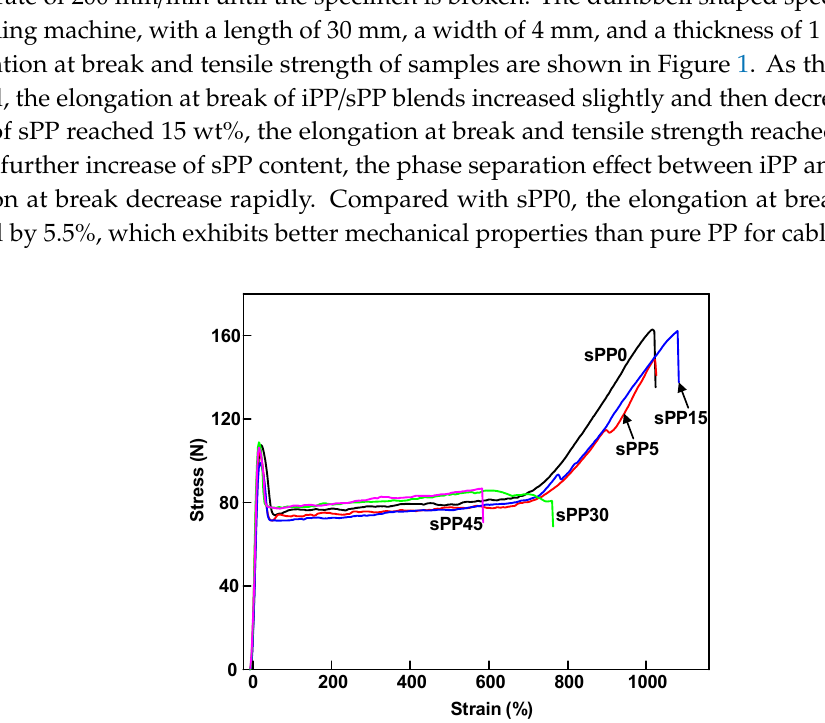
Figure 1. Stress–strain curves of iPP/sPP blends.